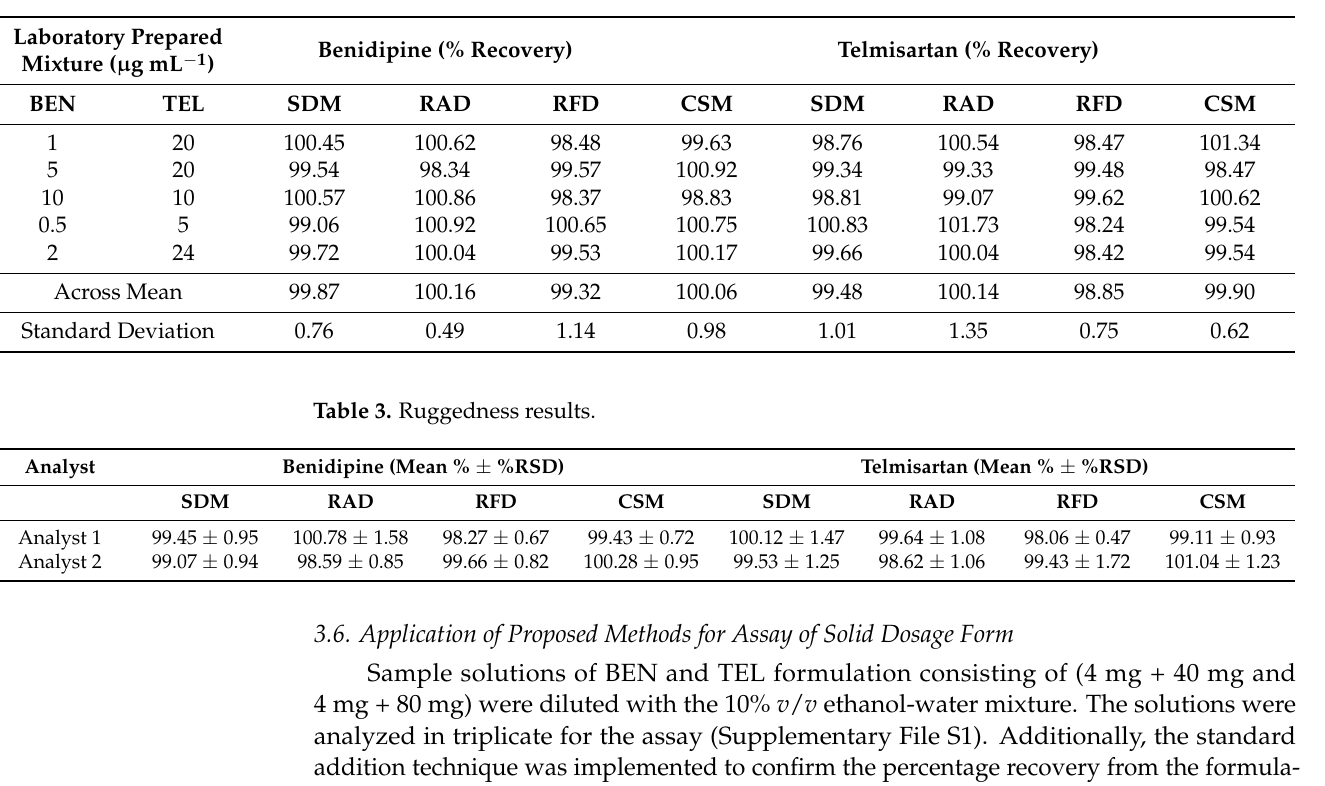
Table 2. Assay results of the laboratory mixed solutions of BEN and TEL.